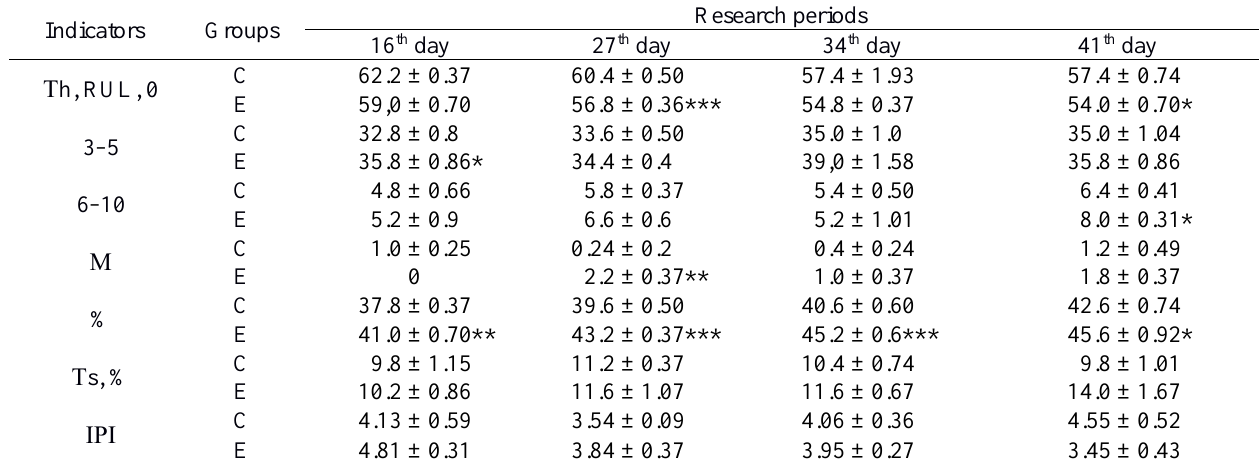
The amount of Th-RUL and Ts and their functional activity in the blood of broiler chickens, % (M ± m; n =